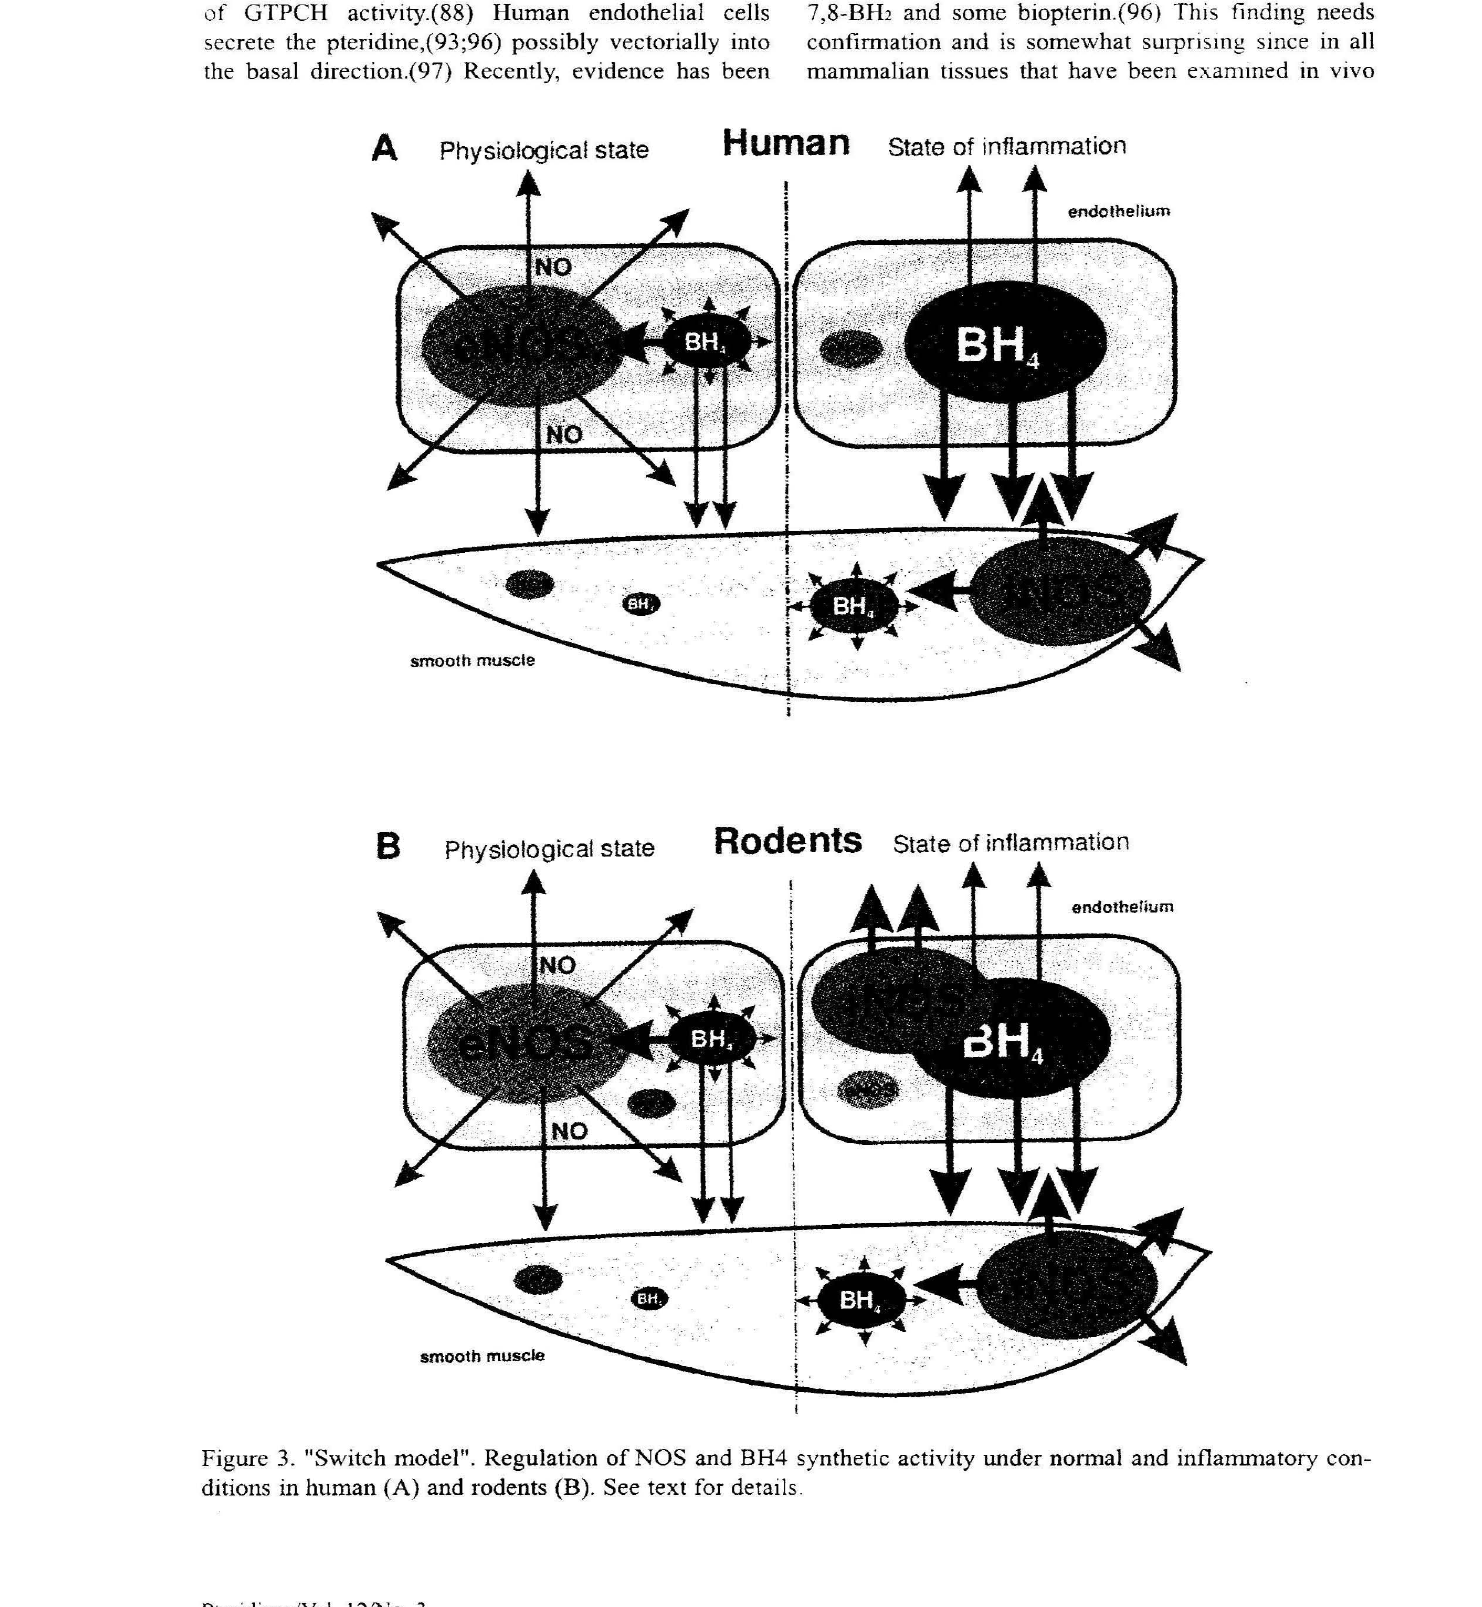
PteridineslVol. l2INo.